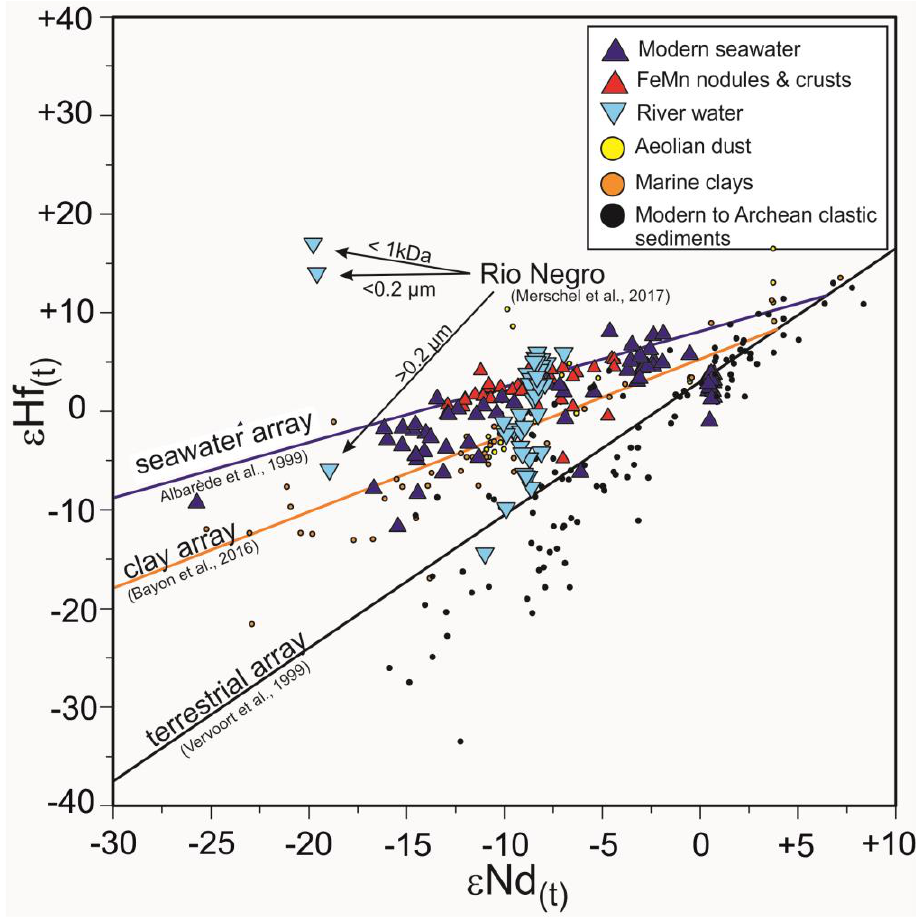
Figure 1. The seawater, clay, and terrestrial arrays relative to initial ɛ Nd (t) and ɛ Hf (t) values of modern seawater (epsilon notation: measured isotope ratios relative to a reference material and multiplied by 10,000 at a certain time), Fe-Mn nodules and crusts, river water, aeolian dust, marine clays, and terrestrial clastic sediments. The Hf-Nd isotope systems are coupled in magmatic systems ( ‘ terrestrial array ’ ), but are decoupled in low-temperature environments due to incongruent Hf weathering of the continental crust. Mineral sorting between fine-grained ( ‘ clay array ’ ) and coarse-grained mineral fractions in the suspended loads of rivers and oceans and during aeolian processes decouple both isotope systems. ɛ Nd (t) and ɛ Hf (t) values are also decoupled in the dissolved fractions of seawater ( ‘ seawater array ’ ) and river water. Note the filter-size-dependent decoupling of ɛ Nd (t) and ɛ Hf (t) values in Rio Negro water. Data are taken from [17,19,21,23 – 31].